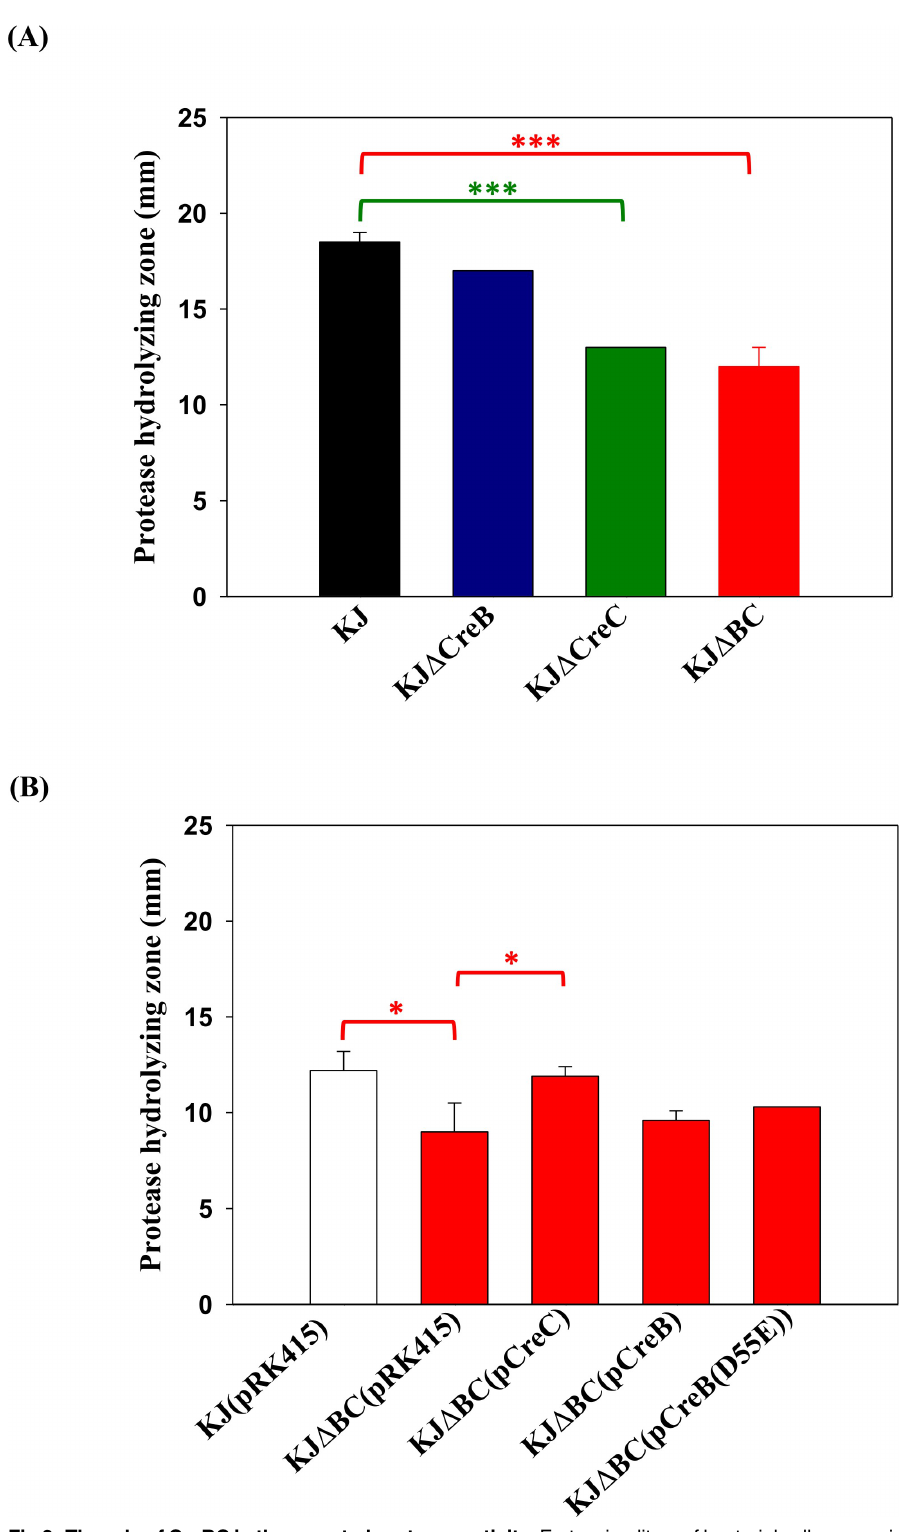
Fig 2. The role of CreBC in the secreted protease activity. Forty microlitersof bacterialcell suspension was dippedonto LB agar containing 1% skim milk. After incubation at 37˚C for 72 hour, the proteolyticactivity of bacteriawas assessed by measuring the transparentzones aroundthe bacteria. Data represent the means from 3 independentexperiments. Error bars representthe standard deviations for three triplicate samples. * ,